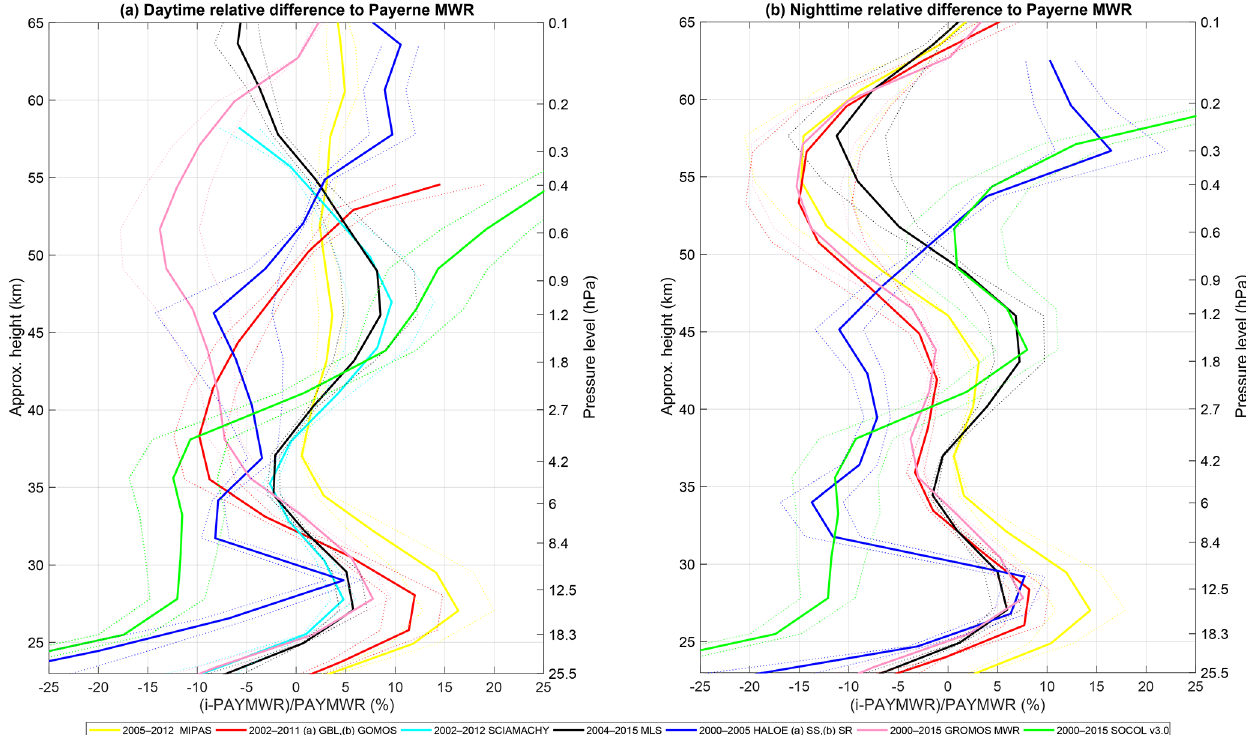
Figure 5. Payerne MWR bias vertical structure: mean of the relative difference between Payerne MWR and satellites MIPAS, MLS, GOMOS, GBL, SCIAMACHY, HALOE ( a SS and b SR) and Bern MWR and SOCOL v3.0 CCM, for (a) daytime (10:00–14:00LST) and (b) nighttime measurements (22:00–02:00LST).